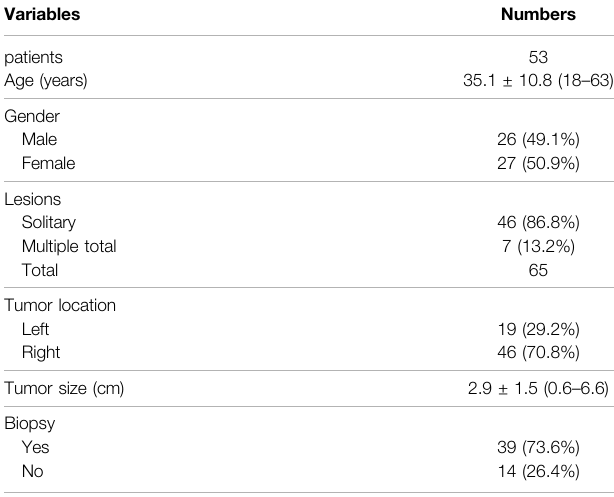
TABLE 1 | Baseline patient and lesion